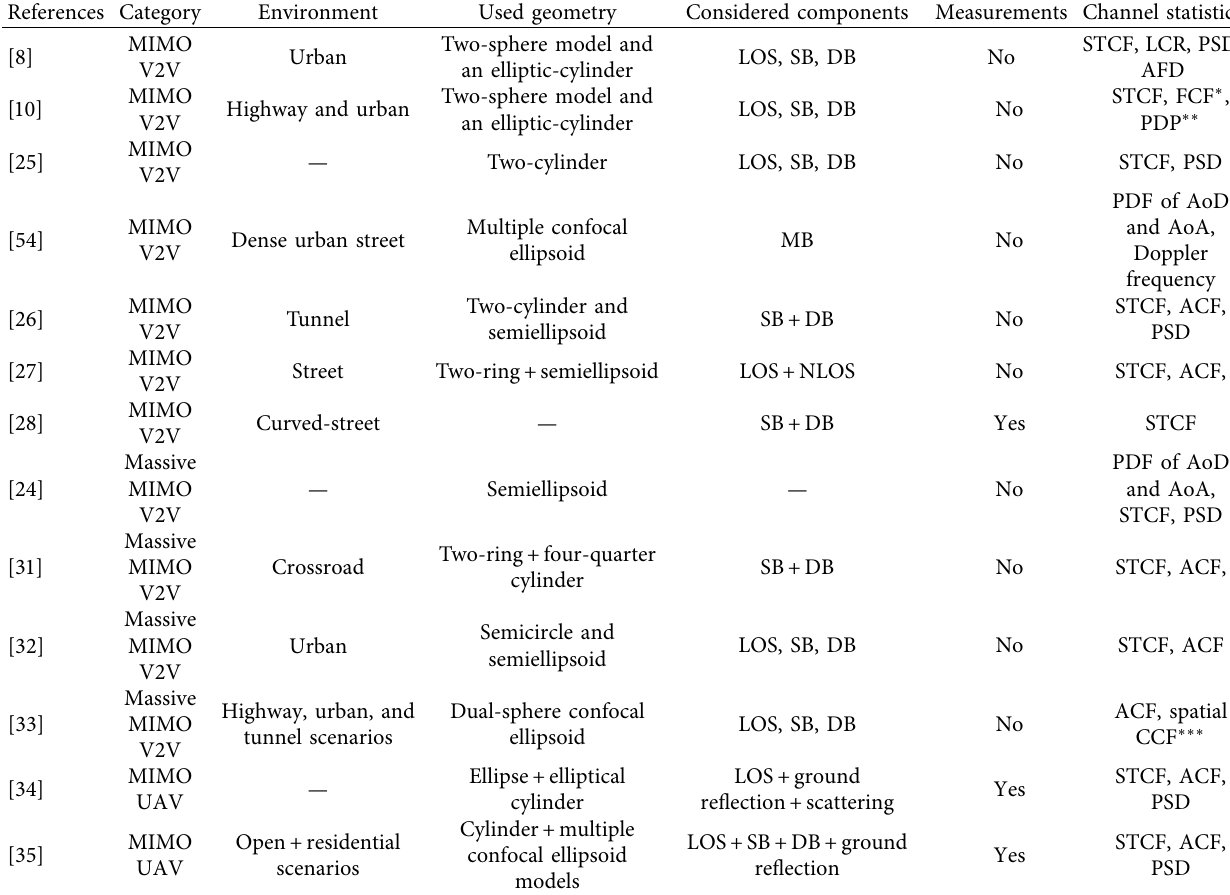
Table 1: Summary of the main characteristics of 3D RS-GBSM channel models.